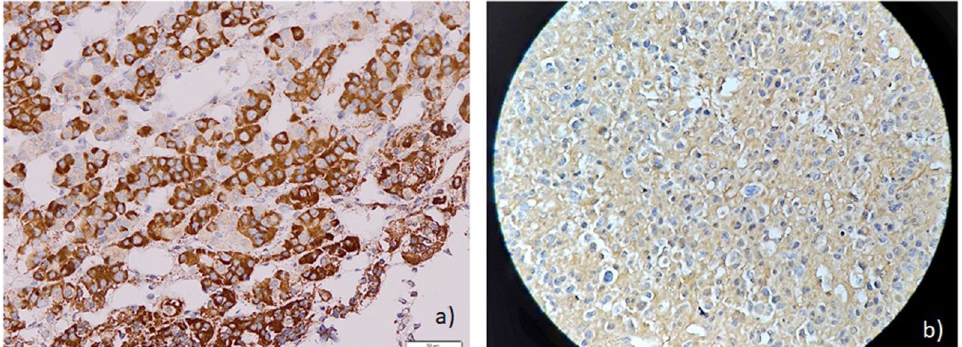
Fig. 3 Immunohistochemical detection of gliomas cells profile. This is representative image of a specimen that positively stained with PD-L1 both in glioma patient ( a ) and primary isolated cell line ( b ). Original magnification: article for this